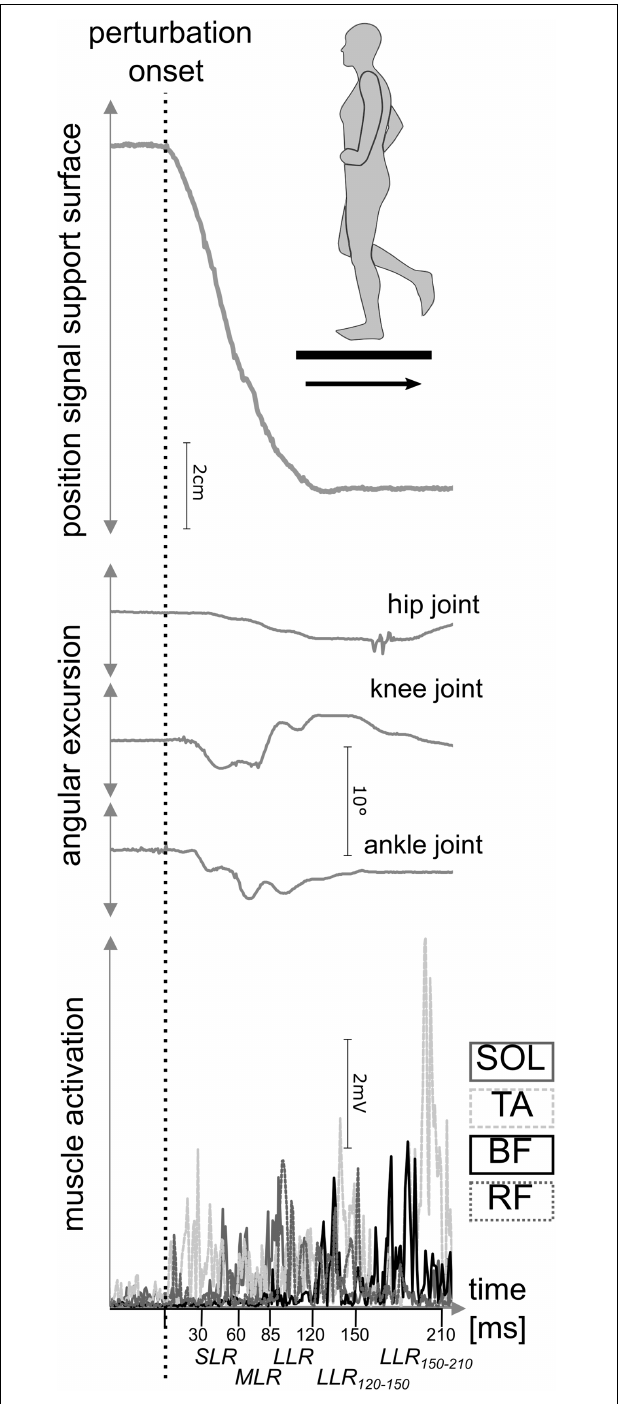
FIGURE 2 | Outcome measures during posterior perturbation of a representative participant. Recording of neuromuscular data (bottom) and kinematic data (middle) during posterior translation of the support surface (top) were carried out. For muscular activation, the soleus (SOL), tibialis anterior (TA), biceps femoris (BF), and rectus femoris (RF) muscles were measured during short- (SLR), medium- (MLR), and long-latency responses (LLR) after perturbation onset. Simultaneously, joint excursions of the ankle, knee, and hip joint were